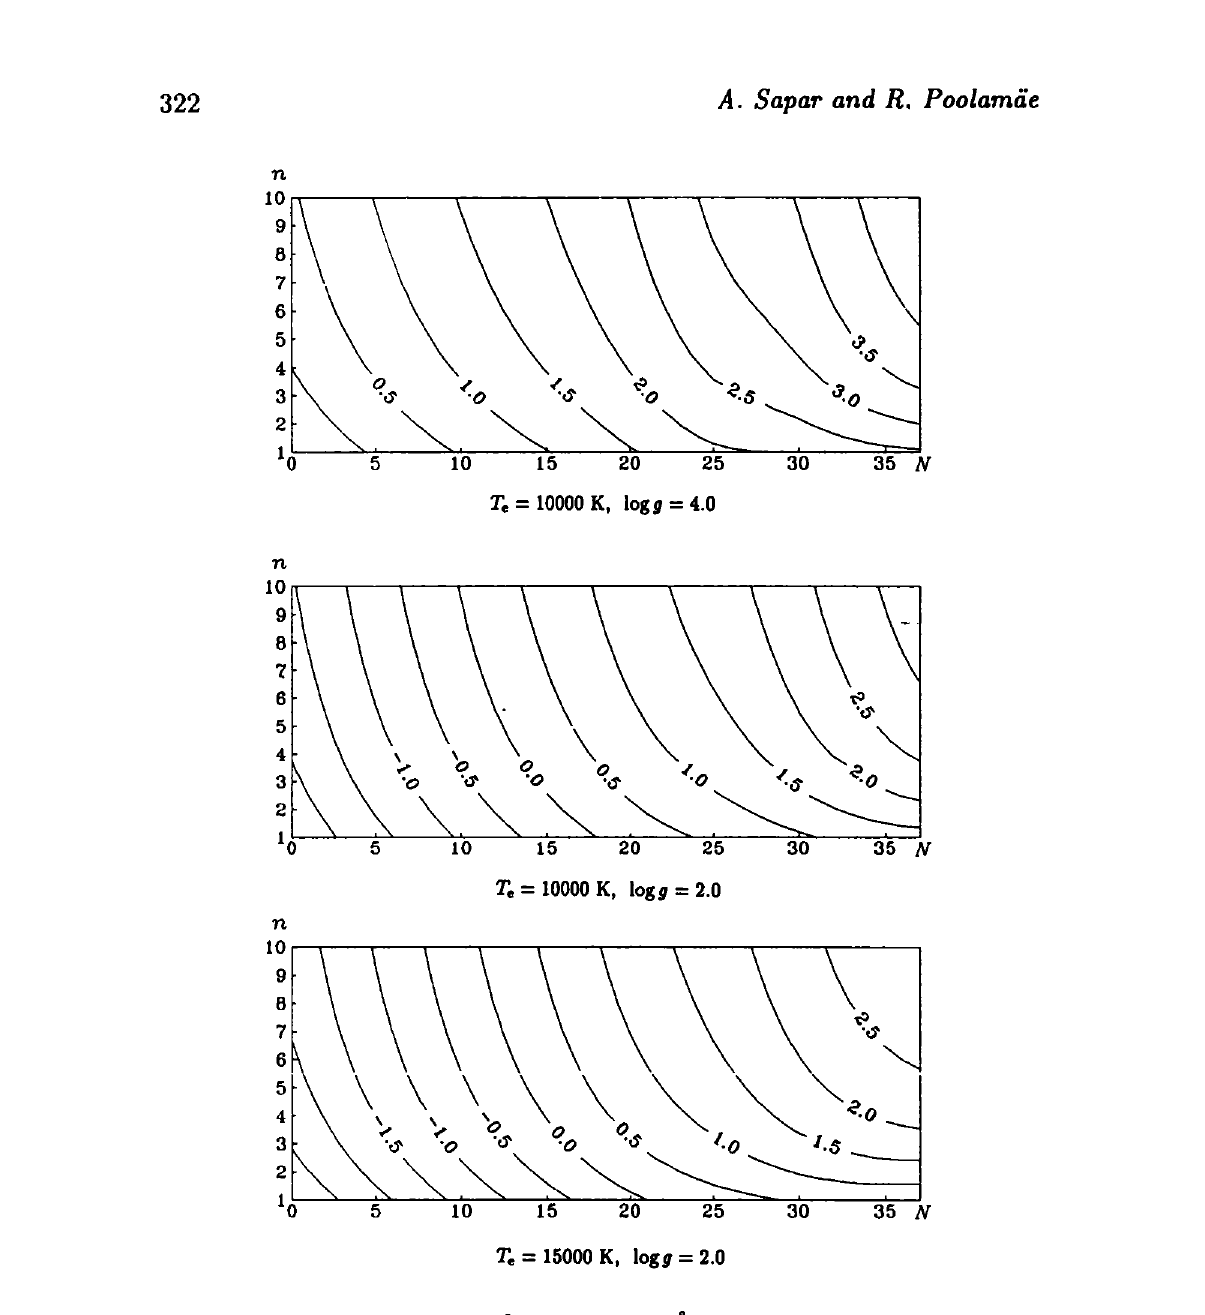
Fig. 5. The isolines of logy at 8000 A for different values of power function Ionisation cross section u~ n . The lines show that at T e = 10000 Κ the electron impacts dominate in the interior layers of atmo- sphere; at T e = 10 000 Κ and log g = 4.0 the electron impacts dominate the whole